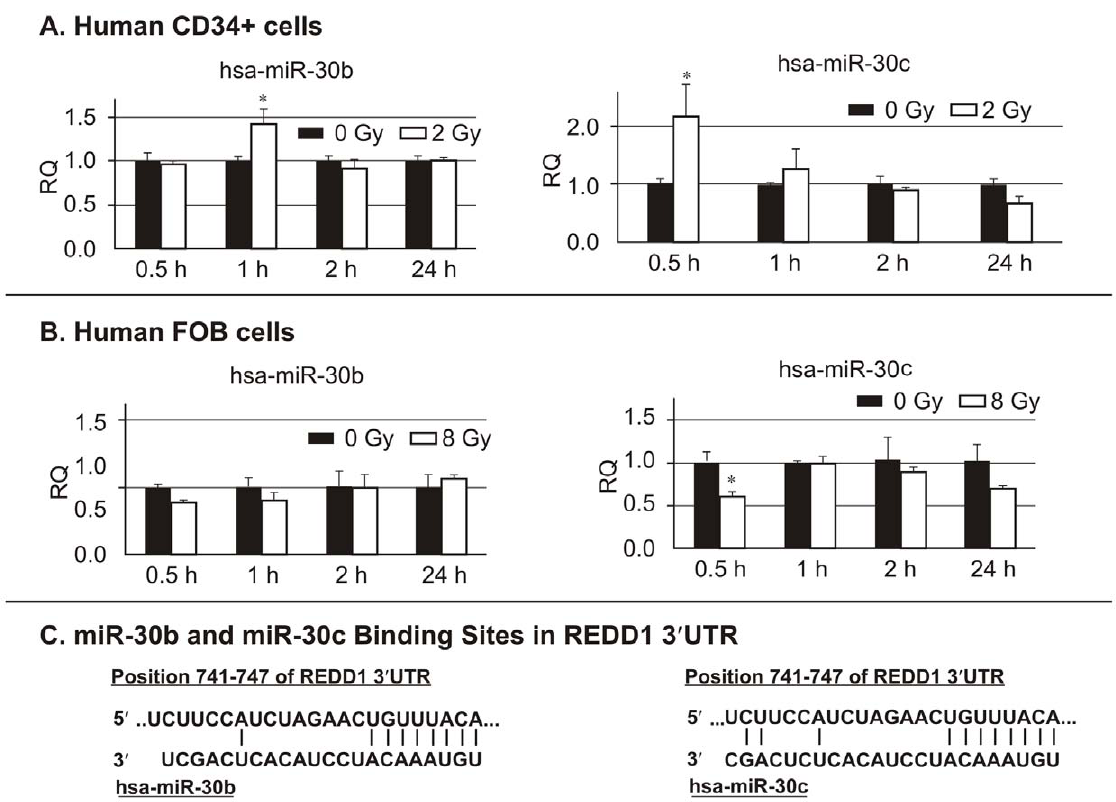
Figure 2. hsa-miR-30 expression after c -irradiation (Quantitative Real Time-PCR). CD34 + and hFOB cells were collected at 0.5, 1, 2 and 24 h after exposure to 2 or 8 Gy radiation, respectively. miR-30b and miR30c expression were evaluated by RT-PCR. U6 was used as a loading control. miR- 30b and miR-30c levels were increased at 0.5 or 1 h after c -irradiation in (A) CD34 + cells, whereas they were decreased or not altered in (B) hFOB cells in response to radiation. Results represent one of 3 independent experiments. Means 6 SD. *, p , 0.05. (C) miR-30b and miR-30c binding sites in REDD1 3 9 UTR are shown. RQ: relative quantification.